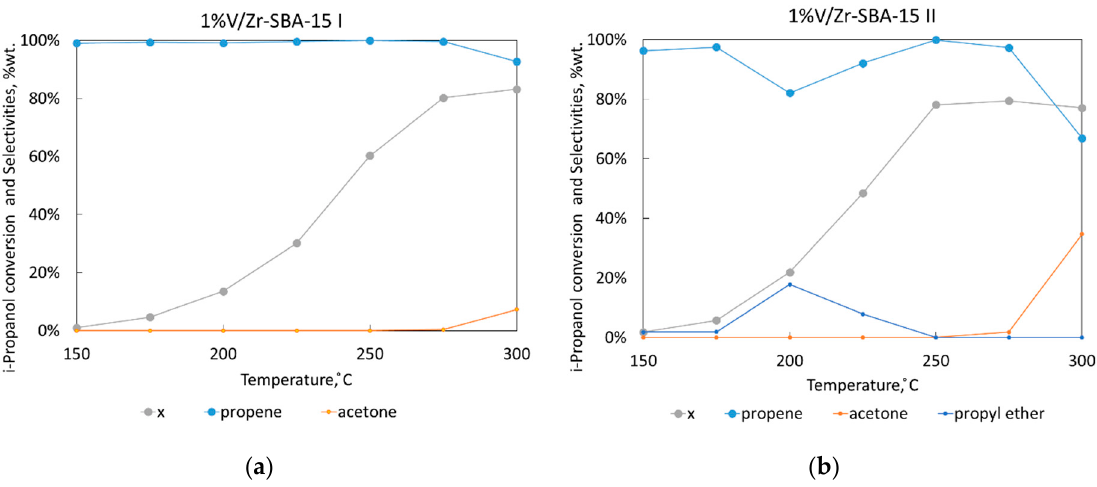
Figure 9. Isopropanol conversion and selectivity to propene and acetone for the 1%V/Zr ‐ SBA ‐ 15 I ( a ) and 1%V/Zr ‐ SBA ‐ 15 II ( b ) catalysts.